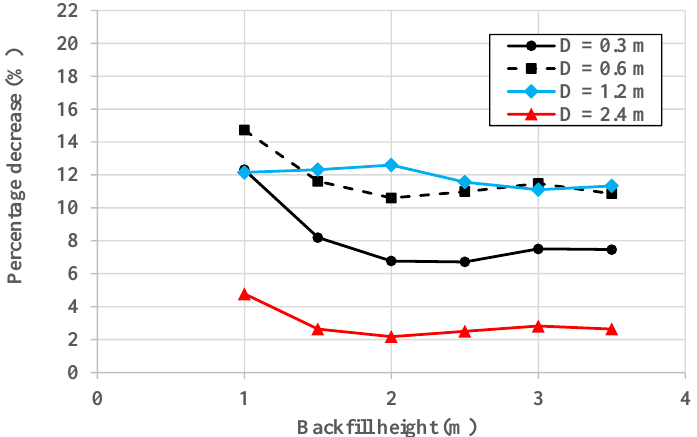
Figure 15. Effect of the pipe diameter and backfill height on the percentage decrease of the maximum bending moment for the TDA 2.